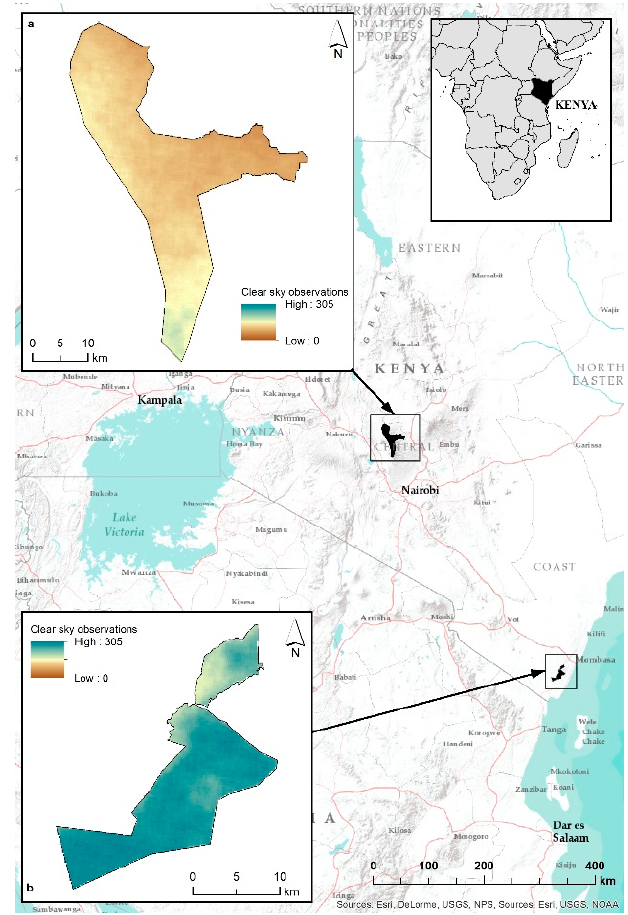
Figure 1. Location of the study areas within Kenya and clear sky observations of Moderate Resolution Imaging Spectroradiometer (MODIS) MOD13Q1 for ( a ) Aberdare National Park and ( b ) Shimba Hills National Reserve.